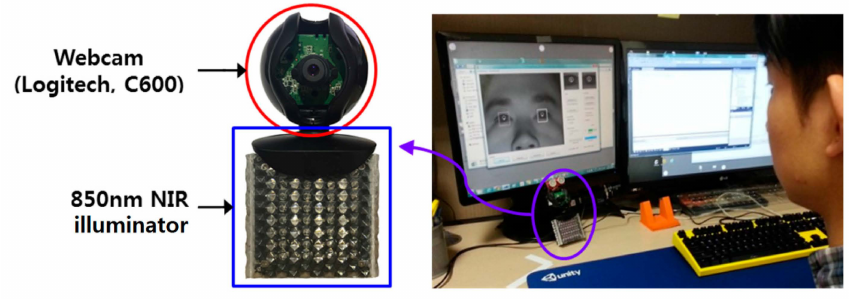
Figure 11. The gaze tracking system and experimental environment used in this